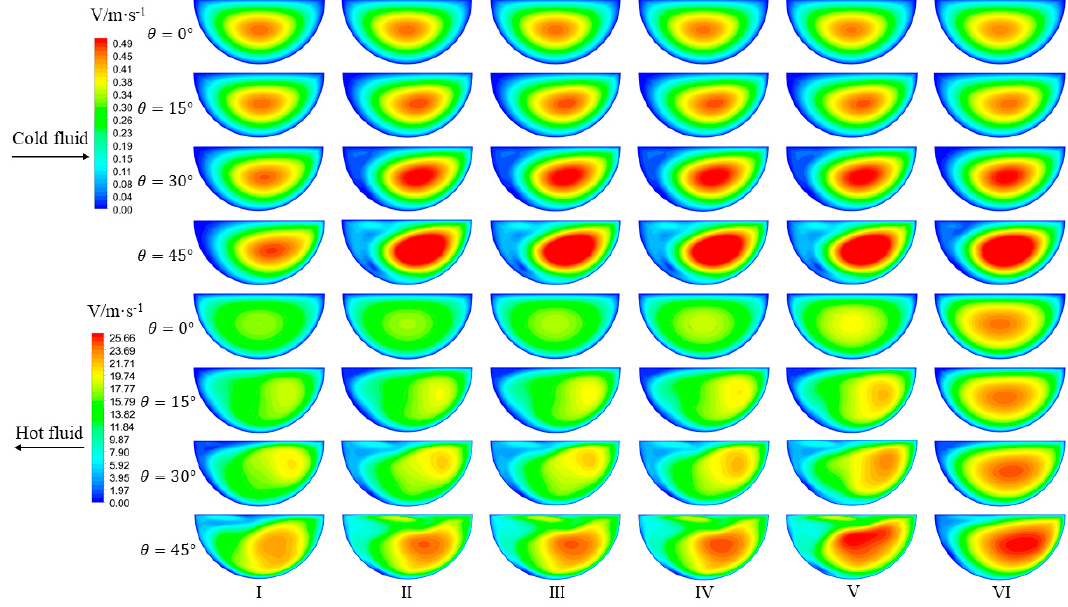
Figure 4. Velocity distribution of different cross-sections along the flow direction.